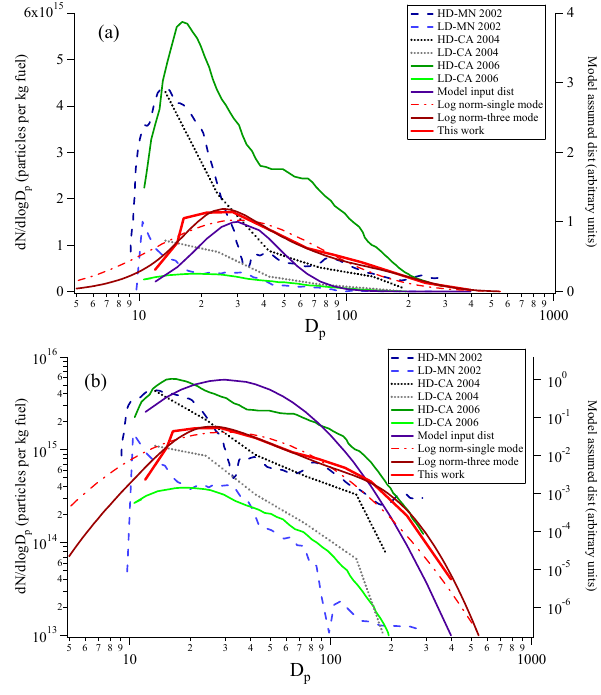
Figure 9. Comparison of the measured emission factor distribution from Mexico City to